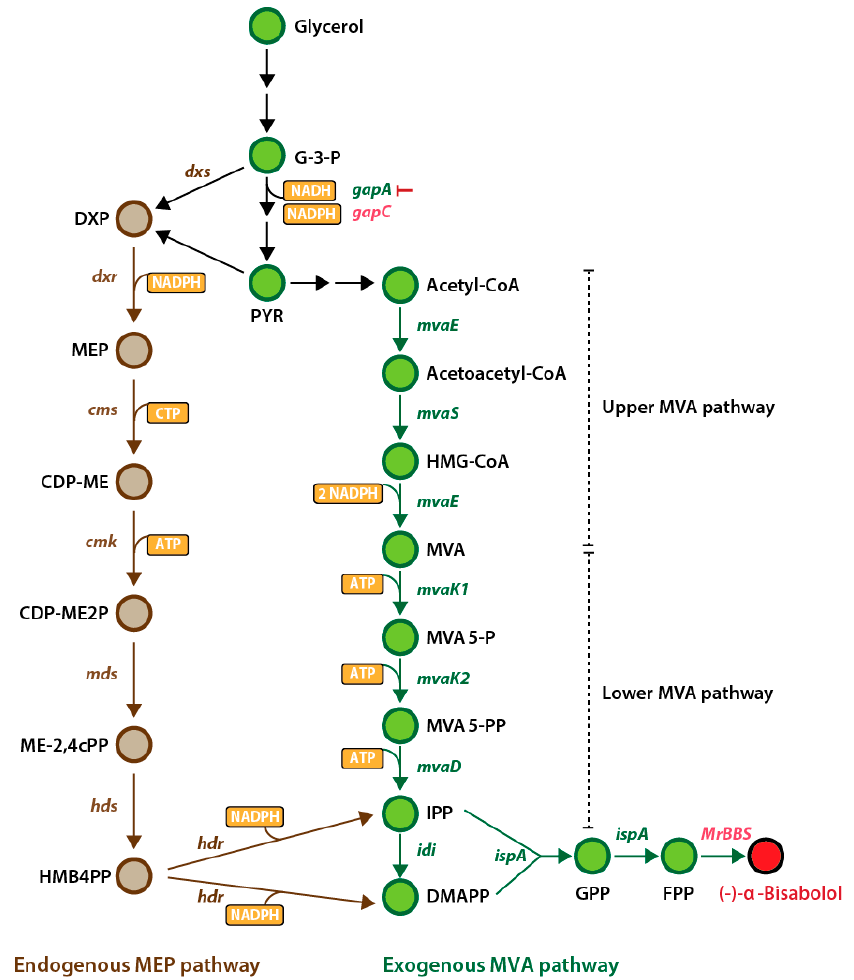
Figure 1. Biosynthetic pathway of ( − )- α -bisabolol in engineered E. coli . The endogenous MEP) pathway consists of DXS (deoxyxylulose-5-phosphate synthase), DXR (deoxyxylulose 5-phosphate reductoisomerase), CMS (2-C-methylerythritol 4-phosphate cytidyl transferase), CMK (4-(cytidine 5 ′ -diphospho)-2-C-methylerythritol kinase), MDS (2-C-methylerythritol 2,4-cyclodiphosphate synthase), HDS ((E)-4-hydroxy-3-methylbut-2-enyl diphosphate reductase), and HDR